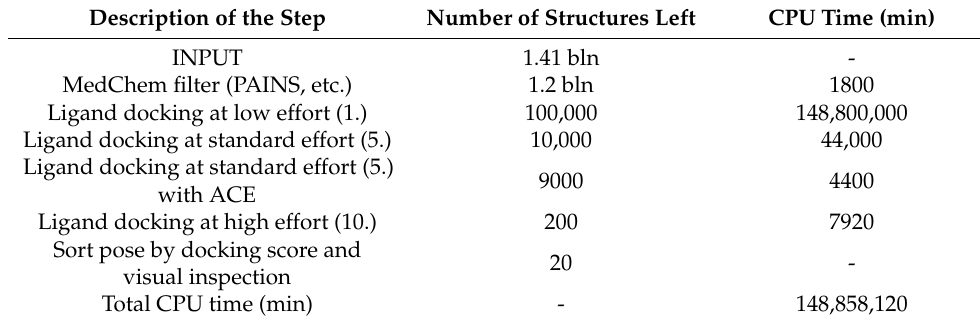
Table 2. Basic roadmap RM1.